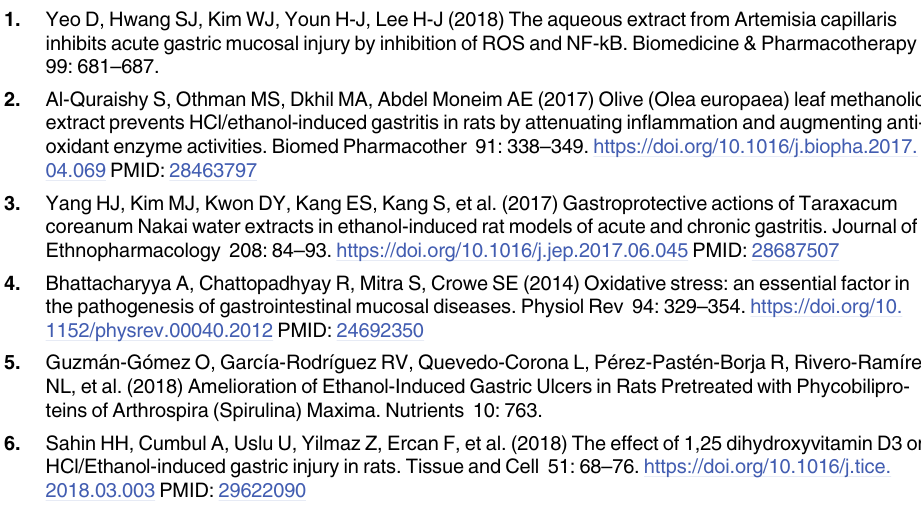
(DOCX) S5 Fig. (+)-ESI-MS of undecylprodigiosin. (DOCX) S6 Fig. (-)-ESI-MS of undecylprodigiosin. (DOCX) S7 Fig. 1 H NMR spectrum of undecylprodigiosin (CDCl (DOCX) S8 Fig. Expanded 1 H NMR spectrum of undecylprodigiosin (CDCl S1 Table. Primer sequences of genes analyzed in real time